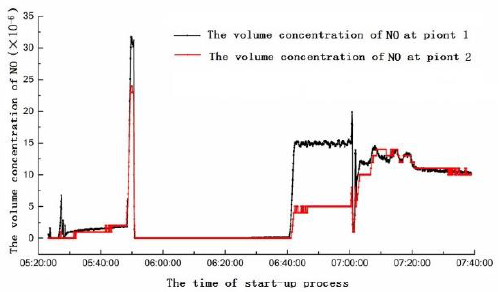
Figure 18. NO concentration at Point 1 and Point 2.